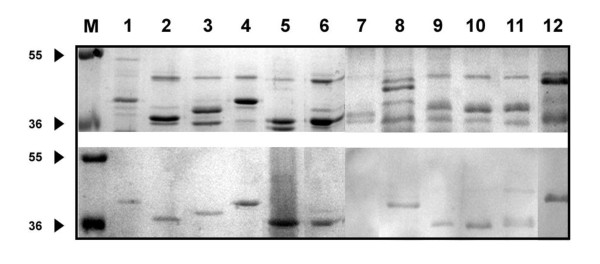
SDS-PAGE (Upper) and Immunoblot (Lower) of OMPs extracted from different Cronobacter strains probed with MAb 2C2. M: Molecular weight marker; 1: C. muytjensii ATCC 51329; 2: C4; 3: C6; 4: C13; 5: Jor93; 6: Jor170; 7: Jor44; 8: Jor112; 9: Jor146A; 10: Jor146B; 11: Jor149; 12: Jor160A.